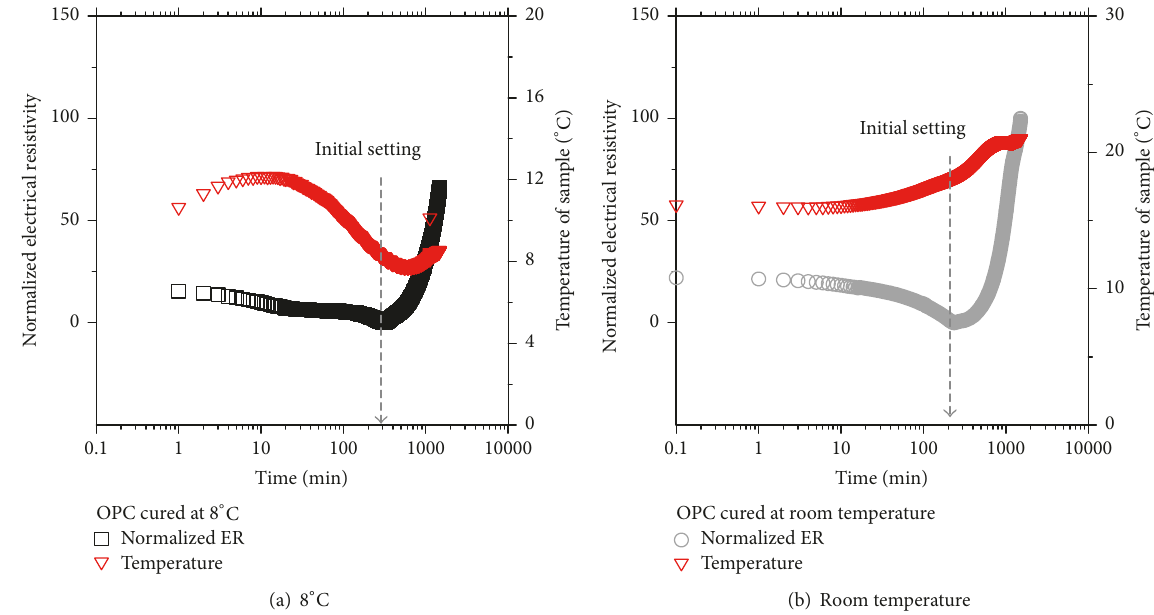
Normalized ER Temperature